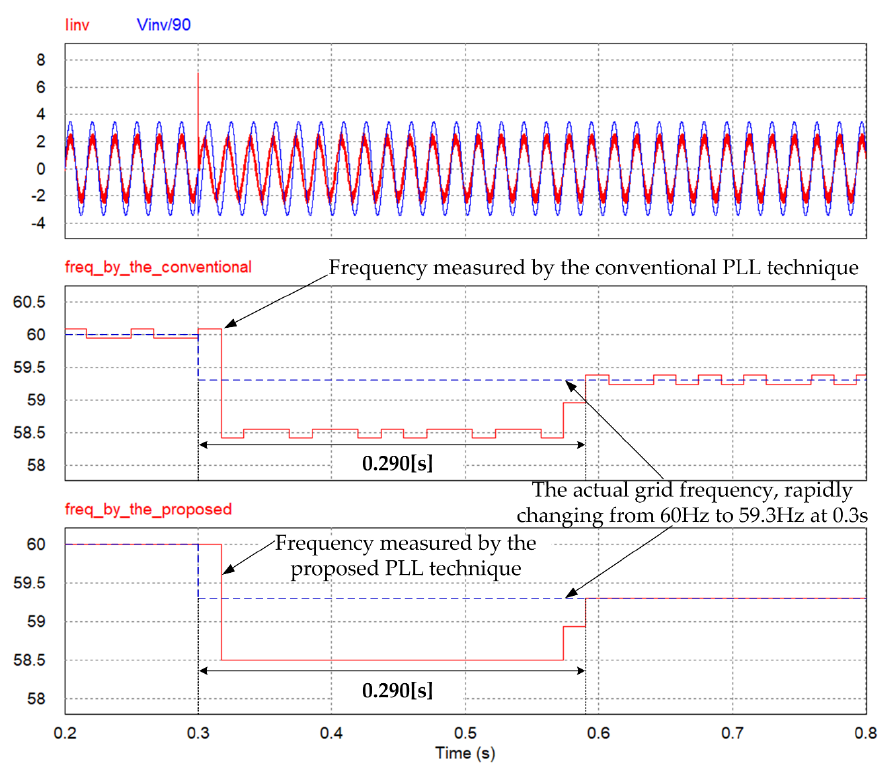
Figure 12. Key waveforms of the PV inverter when the grid voltage frequency is rapidly changing from 60 Hz to 59.3 Hz.